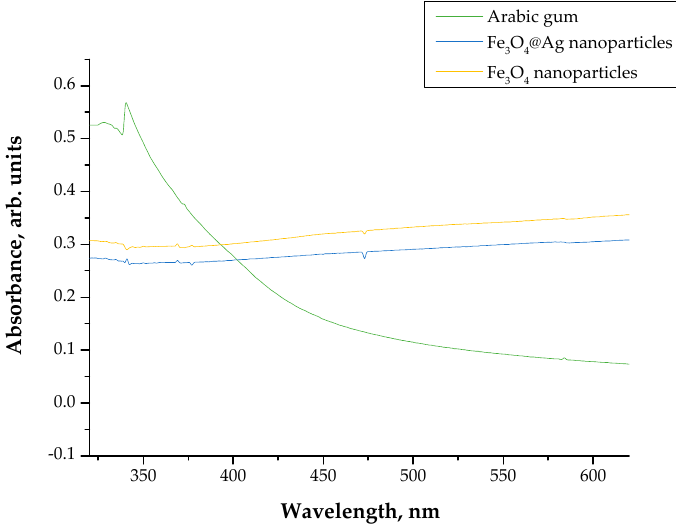
Figure 1. UV-Vis spectrum of the suspension obtained after the synthesis of Fe 3 O 4 @Ag particles using the 1% Arabic gum solution.